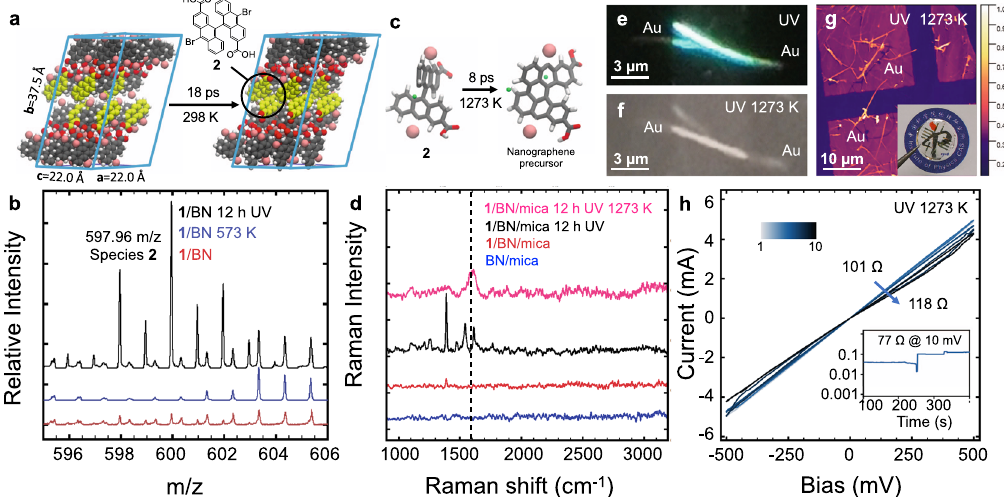
Fig. 4 Photo-crosslinking and annealing into nanographene wires. a DFTB-MD simulated C – C bond formation at 298 K after debromination. b Matrix- assisted laser desorption ionized mass spectrum (MALDI-MS) of 1 after ultraviolet (UV) irradiation on boron nitride (BN) on mica shows formation of species 2 ( m/z = 597.96). Species 2 is not detected when the sample is annealed at 573 K under argon without UV treatment. c The C – H bond breaking DFTB-MD simulation during the high temperature transformation of the supercell in a followed by C – C bond formation. Dissociating H atoms are shown in green. d Raman spectroscopy of an individual nanowire. The 1389 cm − 1 anthracene signal intensi fi es after UV irradiation. After 1273 K 30 min annealing, the 1541 cm − 1 signal which appears after UV irradiation weakens, and the 1602cm − 1 peak (black dash line) broadens. λ ex = 532 nm and 2 mW, 60 s integration time. e , f Photoluminescence (PL) microscopy (480 nm emission at 350 nm excitation) of the nanowire between two gold electrodes after photo-crosslinking, and after 1273 K 30 min annealing. g Laser confocal microscopy bright fi eld image of a nanowire. The inset shows a photo of 1 /BN/mica sample with Au electrodes. h High current I-V characteristics of a single ~200 nm-wide nanowire reveals a resistance of 101 Ω which increases in time. The inset shows the junction stability at 10 mV and low currents.